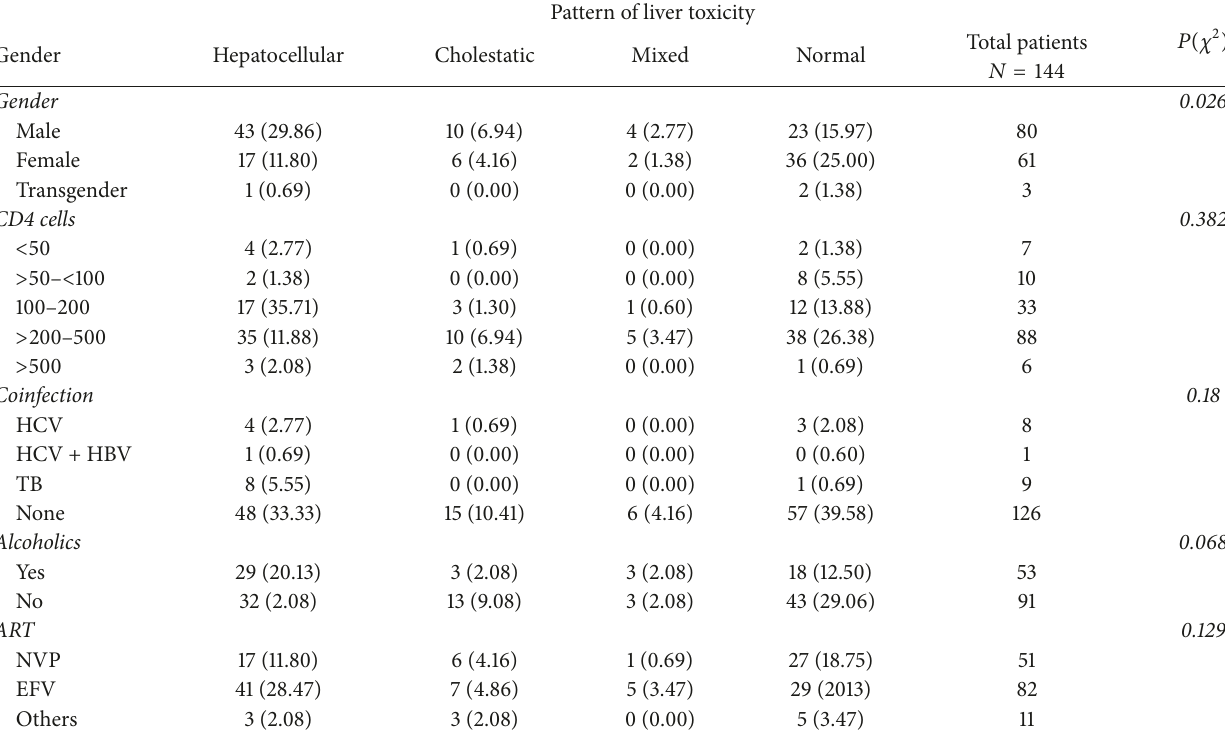
Table 4: Patients characteristics and pattern of liver